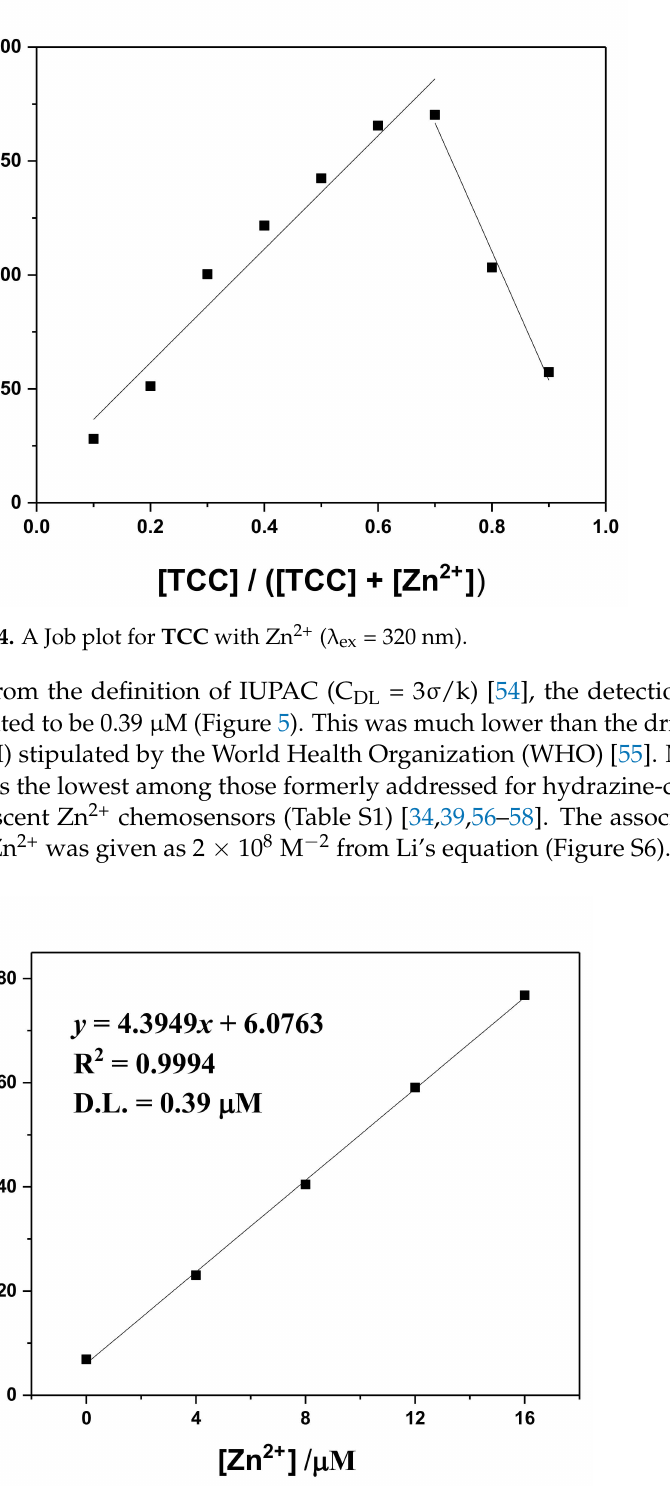
Figure 5. The detection limit for Zn 2+ by TCC (4.0 × 10 − 5 M) based on the fluorescence emission at 450 nm ( λ ex = 320